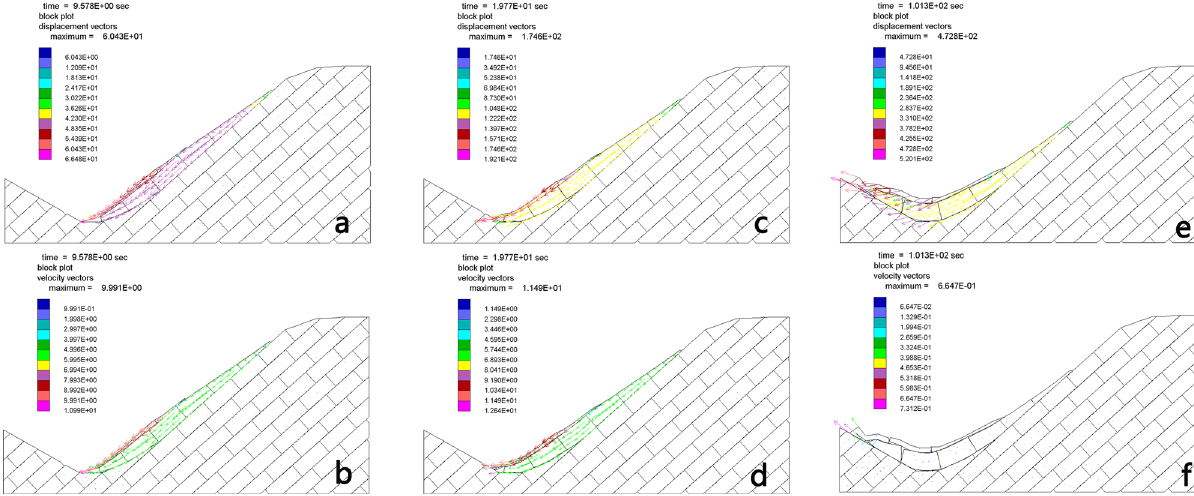
Figure 7. Block movement states of the Tangjiashan landslide at different times. After 100 s, landslide dam- created lake is formed. ( a – c ) are displacement vectors of different times; ( d – f ) are velocity vectors of different times. We produced the figures using UDEC (Ver.6.0) software (https ://www.itasc acg.com/softw